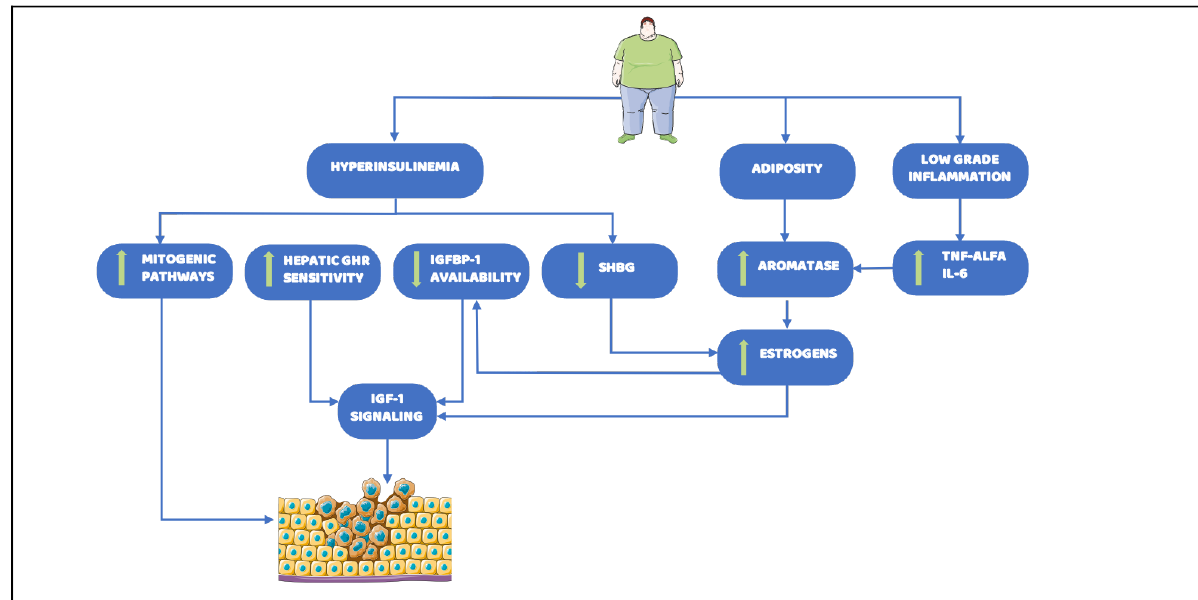
Figure 2. Main biological mechanisms linking obesity and cancer risk. Obesity constitutes major determinants of the increasing incidence and prevalence of cancer. Several aspects underlying obesity, such as hyperinsulinemia, adiposity, and low grade inflammation, have been found as the major causes leading to cancer onset. Downward arrow indicates a decrease, whereas upward arrow indicates an increase. Abbreviations: GHR: Growth Hormone Receptor; IGFBP-1: Insulin-like growth factor-binding protein 1; SHBG: Sex Hormone Binding Globulin; TNF-alfa, Tumor Necrosis Factor-alfa; IL-6: Interleukin-6; IGF-1: Insulin Growth Factor-1. Parts of the figure were drawn by using pictures from Servier Medical Art. Servier Medical Art by Servier is licensed under a Creative Commons Attribution 3.0 Unported License.